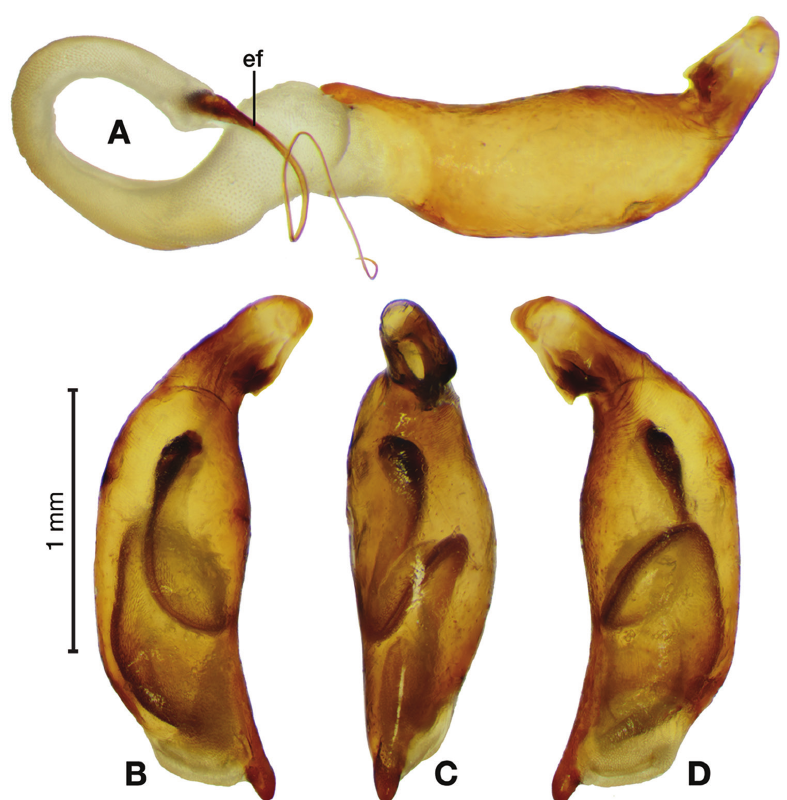
Figure 108. Digital images of male genitalia of Serrimargo schenklingi (Dupuis). A left lateral aspect, en- dophallus everted B right lateral aspect C ventral aspect D left lateral aspect. Legend: ef endophallic